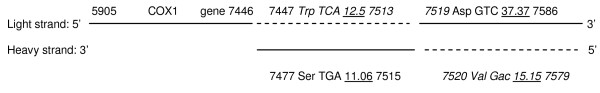
Scheme of the human mitochondrial genome region templating for sense tRNAs Ser UGA and Asp GUC. Continuous lines indicate expressed sense genes, dashed lines hypothetically expressed antisense genes. tRNAs are indicated by their cognate amino acid, followed by the anticodon detected by tRNAscan-SE http://lowelab.ucsc.edu/tRNAscan-SE/ and the structural component of the Cove index of that tRNA. Hypothetical antisense tRNAs are in italics. Gene positions on the mitochondrial genome are indicated according to the standard in Genbank (NC_012920). The 5' flank of the antisense of tRNA Ser UGA is processed by sense RNA maturation by default because it is flanked by the mitochondrial protein coding gene COX1, its 3' flank because of its vicinity with sense tRNA Asp GUC. Normal sense RNA maturation processes only the 3' flank of the hypothetical antisense of sense tRNA Asp GUC. Extremities of tRNAs and their anticodons are as detected for these sequences by tRNAscan-SE.